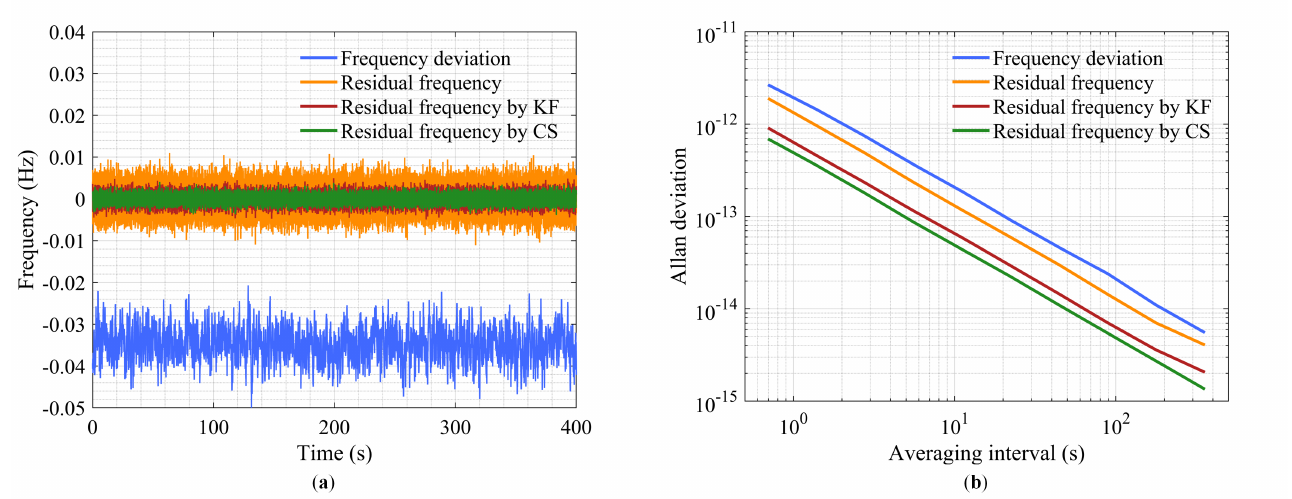
Figure 11. Residual frequency and Allan deviations. ( a ) Frequency deviation and the residual frequency are derived by differentiating the imaging phase difference in Figure 9 and the residual phases in Figure 10, respectively. ( b ) Allan deviations of ( a ).